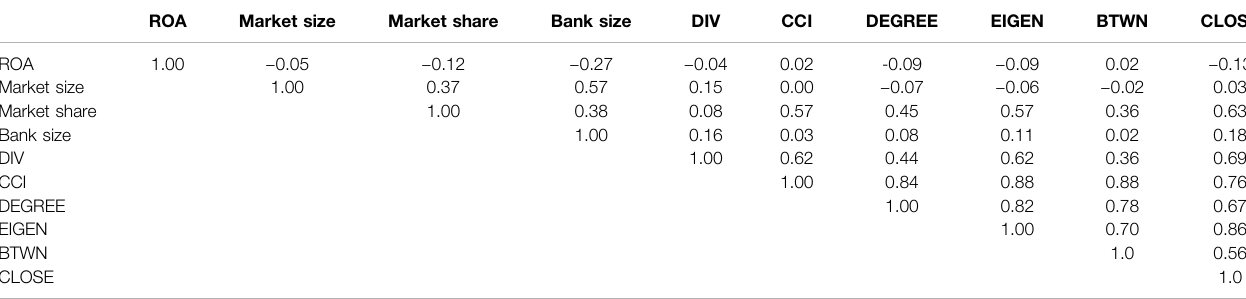
TABLE 2 | Pearson correlation of regression variables.